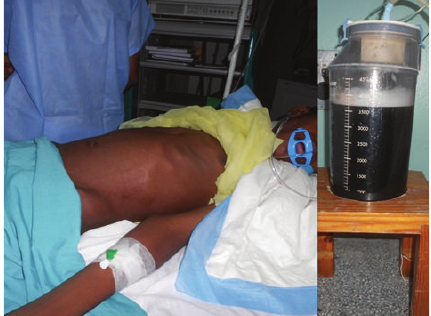
Figure 7: Abdomen remains flat one year after